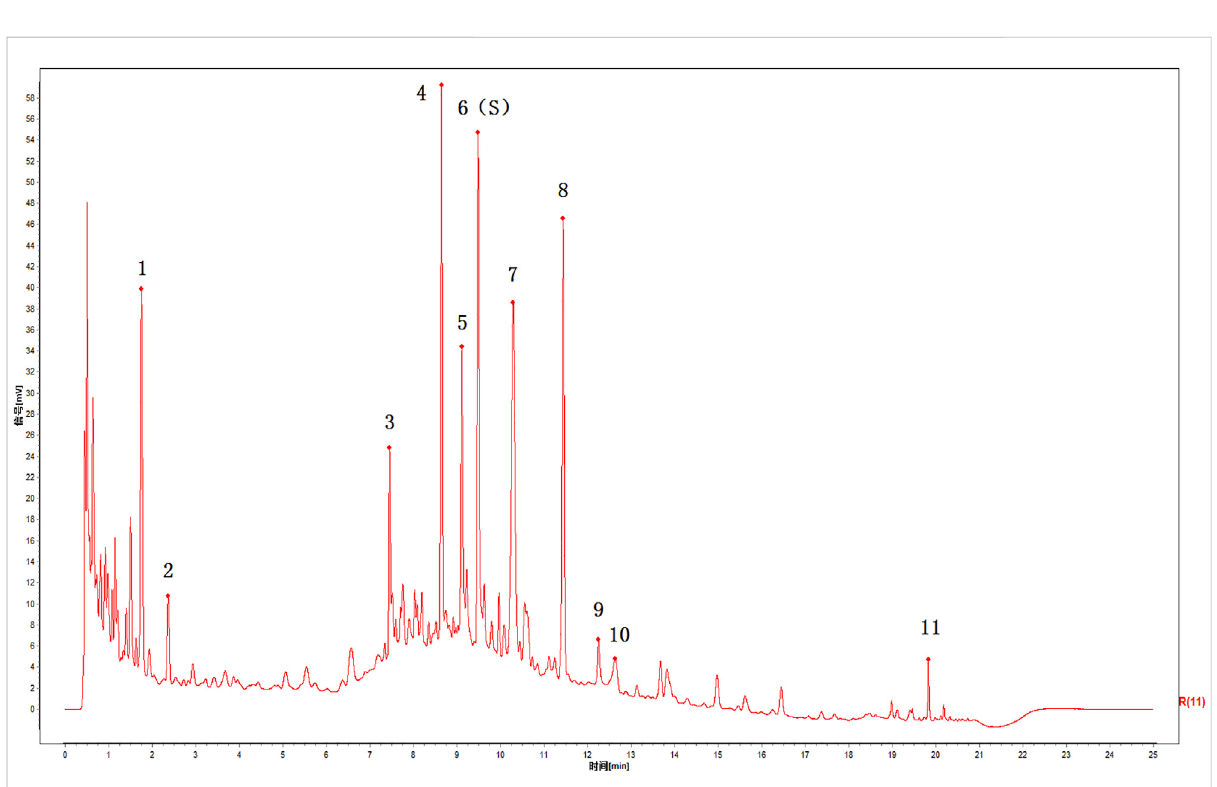
FIGURE 2 UPLCchromatogramsofZFTG.6(S):paeoni fl orinbelongsto Paeoniaveitchii Lynch.(ChiShao,Ranunculaceae)inNorthwestChina,4: